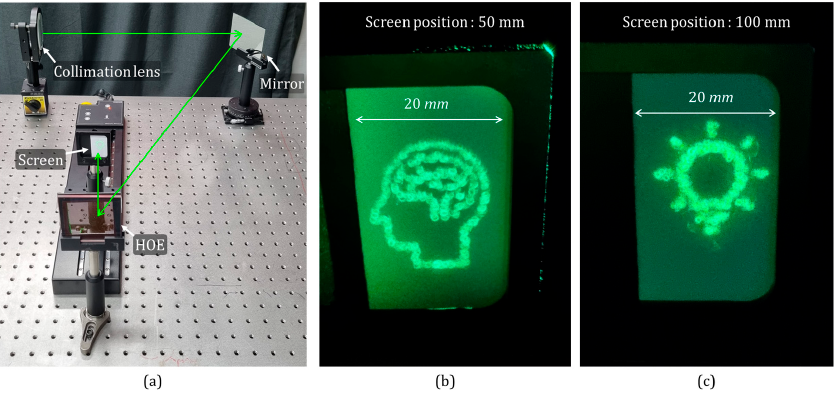
Figure 8. Experimental results for short throw interconnective holographic projection (Video S2: visualization 2). ( a ) Experimental set up and observation for ( b ) the human head icon at z 1 and ( c ) the light bulb icon at z 2